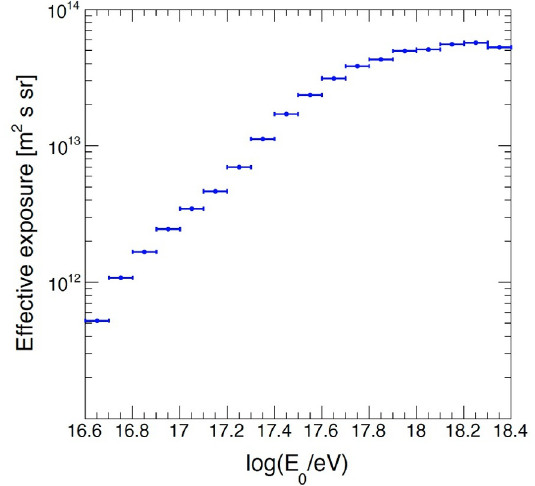
Figure 4. E ff ective exposure in this analysis. The e ff ective expo- sure is expressed as a function of the true energy. This exposure is evaluated by the MC